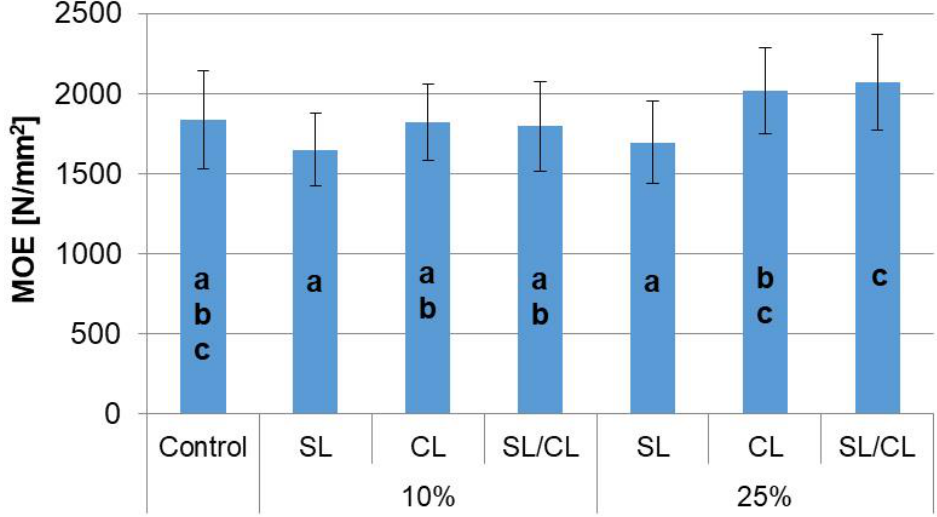
Figure 5. Modulus of elasticity of particleboards. a,b,c—homogenous group by Tukey test. The observed relationships are confirmed by the results of the research presented by Moulan [23], who showed that the increase in the share of hemp shives in the core layer improves its MOR and MOE. Also, Li et al. [42] show that the increase in the share of hemp shives in a single-layer particleboard increases the bending strength and modulus of